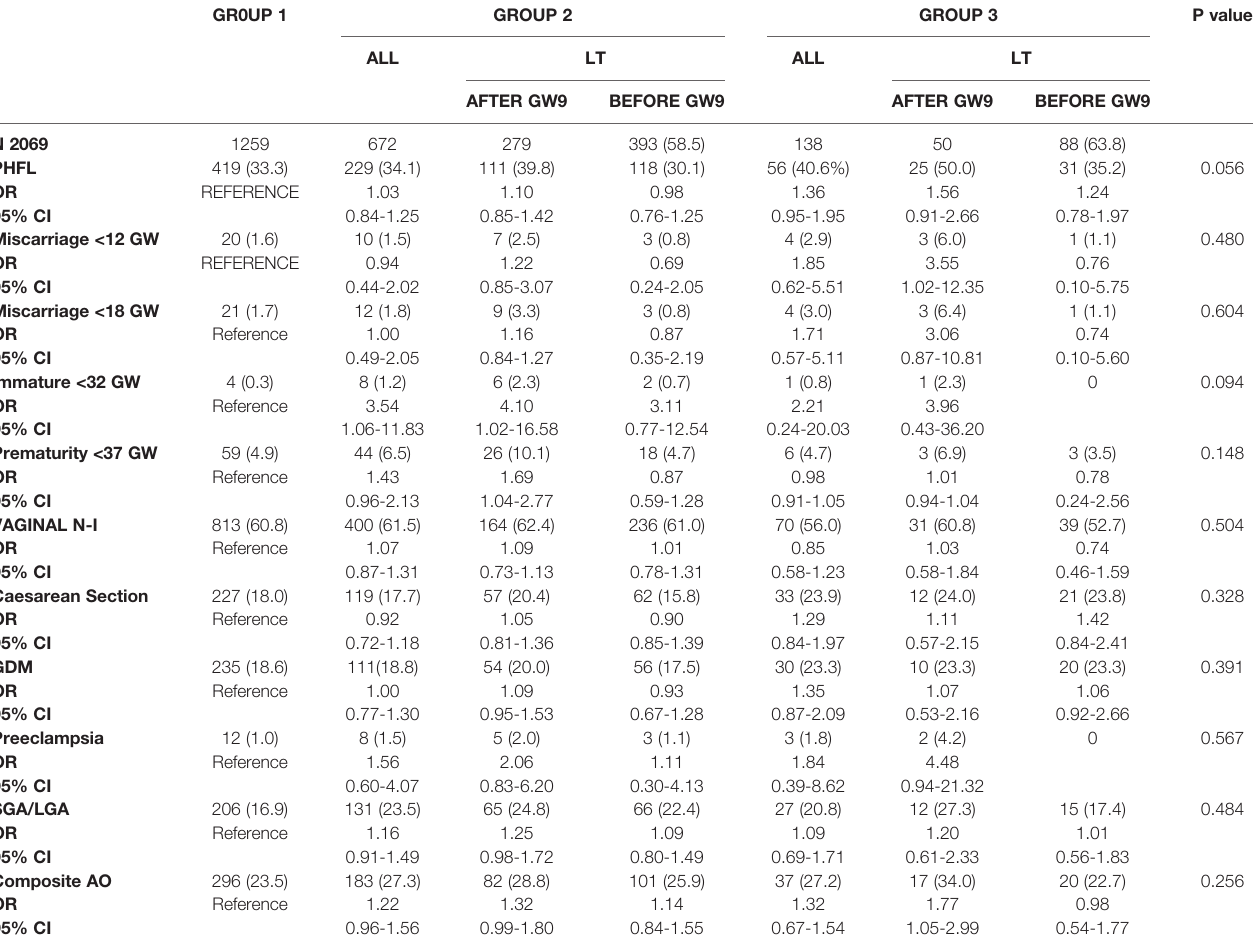
TABLE 4 | Evolution of gestation by groups, and in relation to the beginning of the levothyroxine treatment (LT) before GW9 or later/did not receive it. GR0UP 1 GROUP